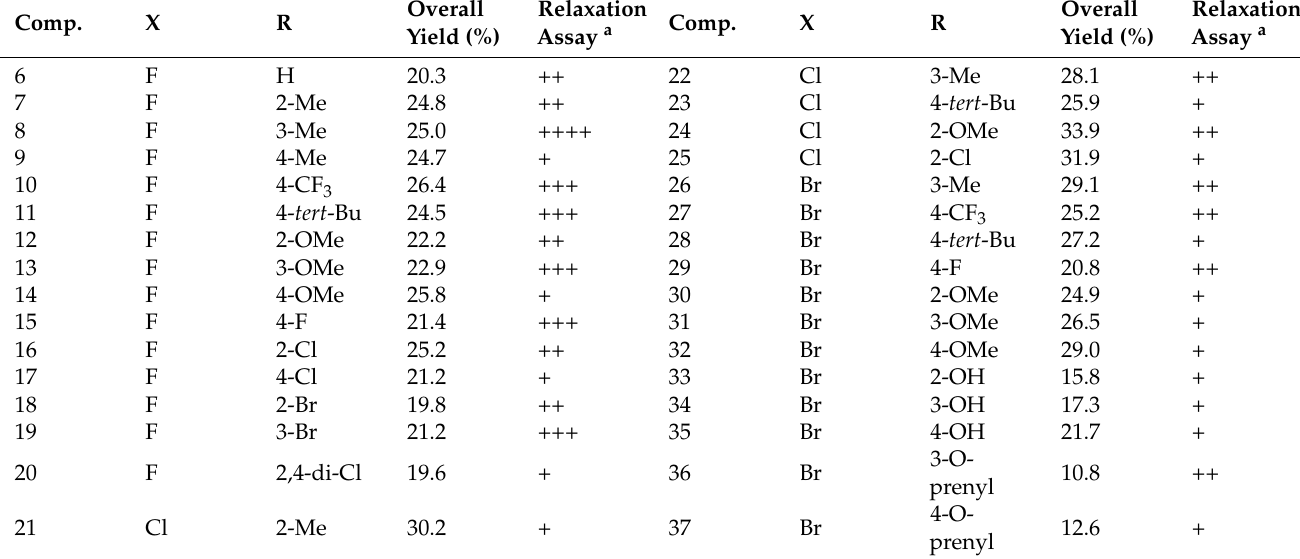
Table 1. Top1 inhibitory activities of synthesized